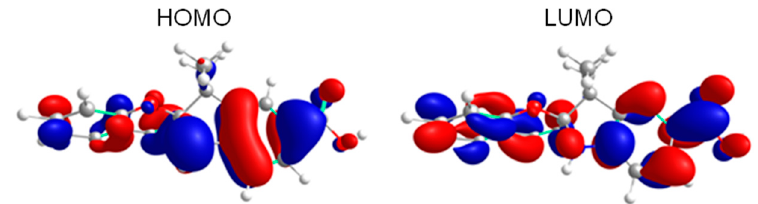
Figure 9. HOMO and LUMO orbitals involved in the S 0 → S 1 transition of spiropyran 7 obtained at PBE1PBE / jun-cc-pVTZ level of theory in PBE1PBE/jun-cc-pVTZ level of theory in dichloromethane.